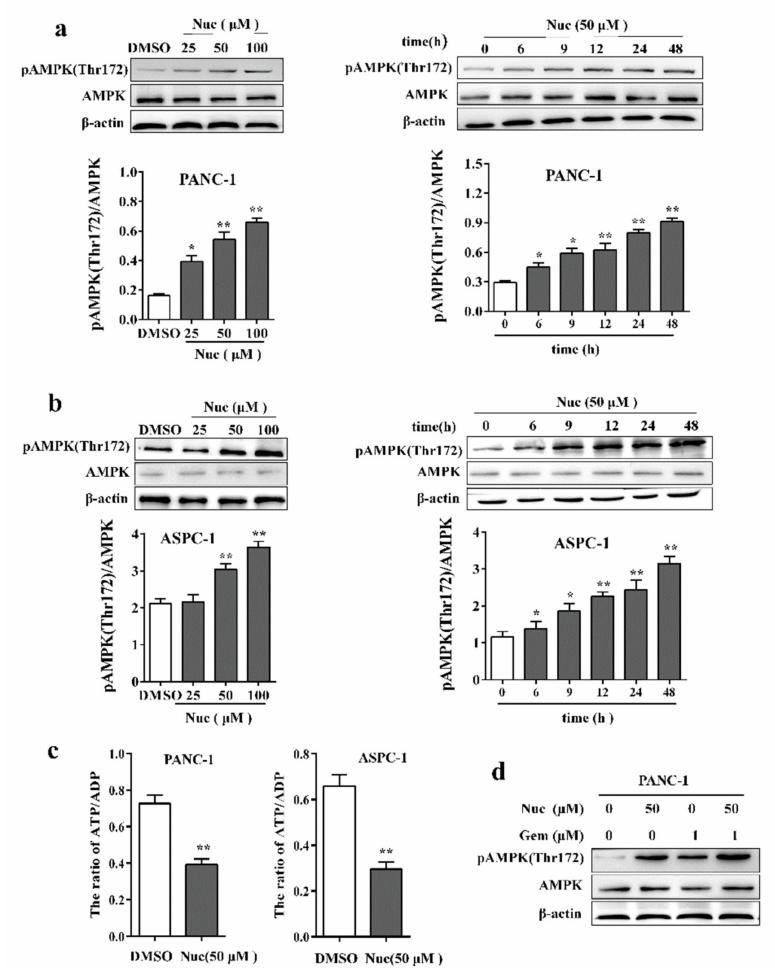
Figure 2. Nuciferine activates AMPK in PANC-1 and ASPC-1 cells. ( a , b ) The whole-cell lysates were prepared and subjected to western blot for pAMPK(Thr172) and AMPK, and relative density between AMPK and pAMPK(Thr172) was determined. ( c ) Levels of ATP and ADP were detected and the ratio of ATP to ADP was calculated. ( d ) After treatment with nuciferine and / or gemcitabine, protein level of AMPK and pAMPK(Thr172) was determined. Nuc, nuciferine; Gem, gemcitabine. * p < 0.05 or ** p < 0.01 versus DMSO-treated control